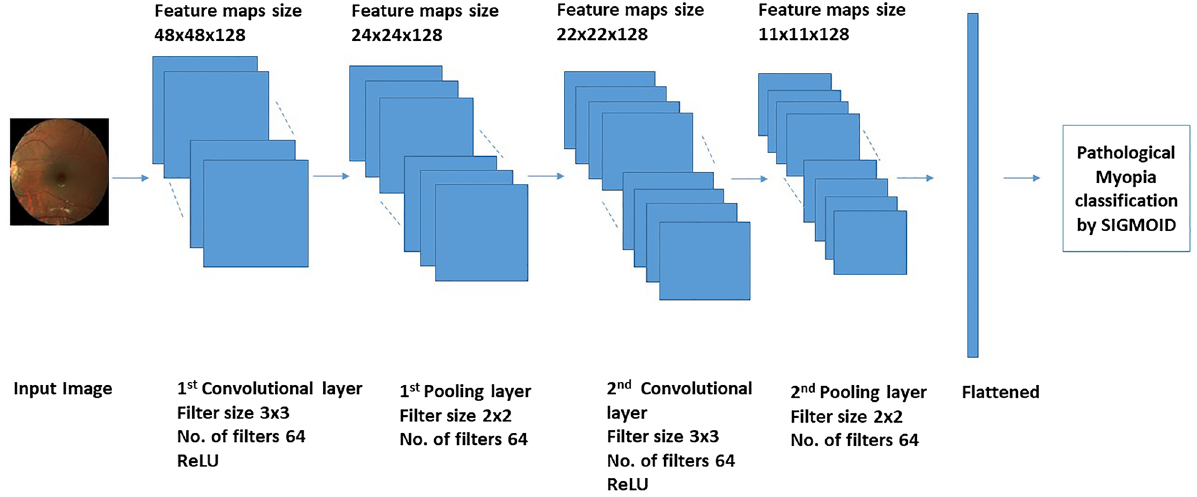
Figure 10. The best performing CNN model i.e.